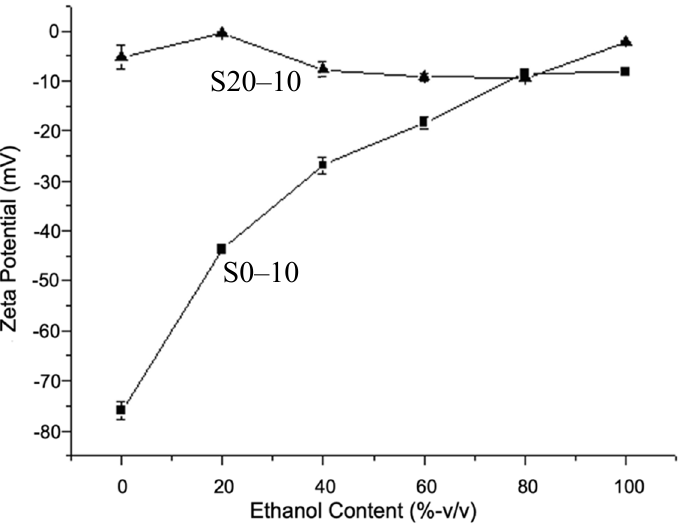
Figure 3. Zeta potentials of 1 wt.% S0-10 ( ■ ) and S20-10 ( ▲ ) ionomers in an ethanol/H 2 O mixture.